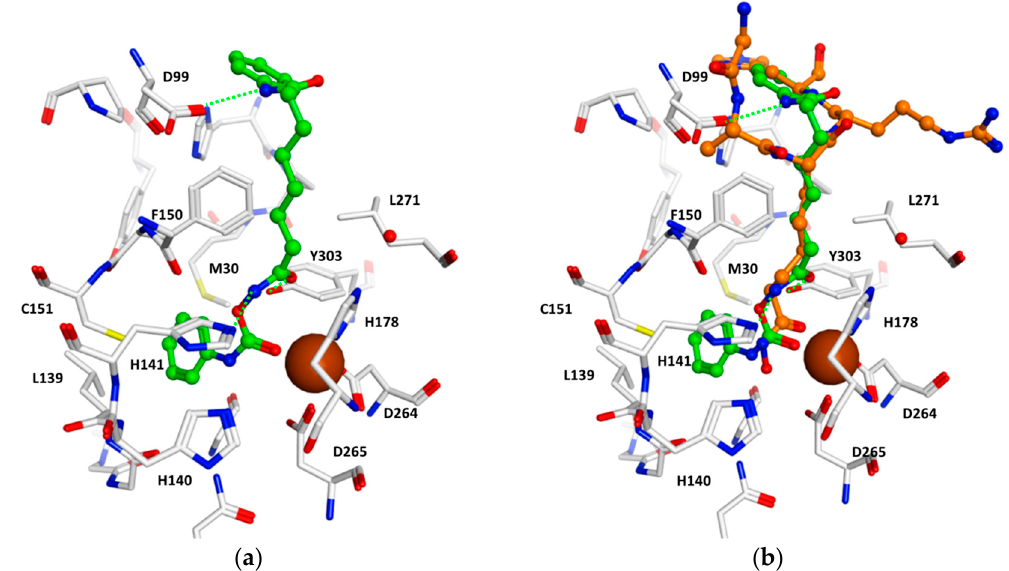
Figure 1. Docking results for HDAC1. ( a ) Interaction of 2d (green) with HDAC1; ( b ) comparison of the docking pose for 2d and the crystal structure of HDAC1 in complex with a hydroxamate peptide derived inhibitor (orange). The zinc ion is shown as a brown ball, and hydrogen bonds are drawn as dashed green lines.